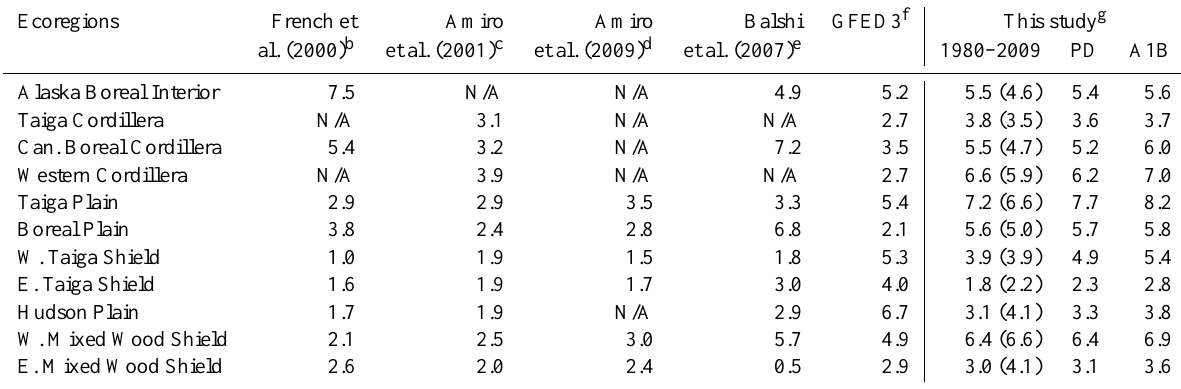
Table 4. Fuel consumption a in boreal ecoregions, as reported by recent studies. Ecoregions French